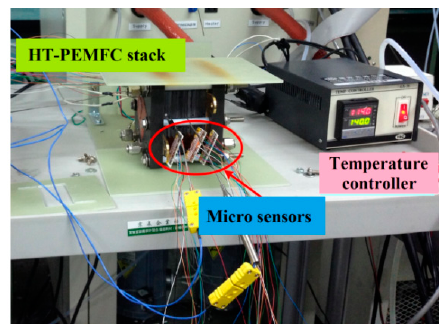
Figure 7. HT-PEMFC stack as the temperature calibration benchmark to calibrate the temperature of the five-in-one micro-sensors.